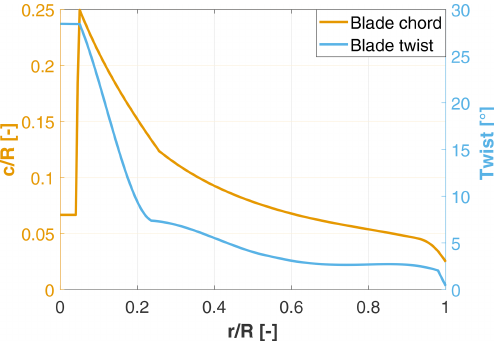
Figure 2. Chord and twist distributions along the